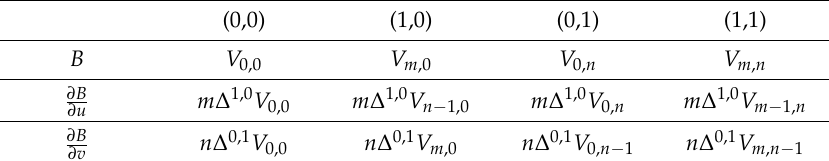
Table 1. Characteristics at the Boundary of B é zier